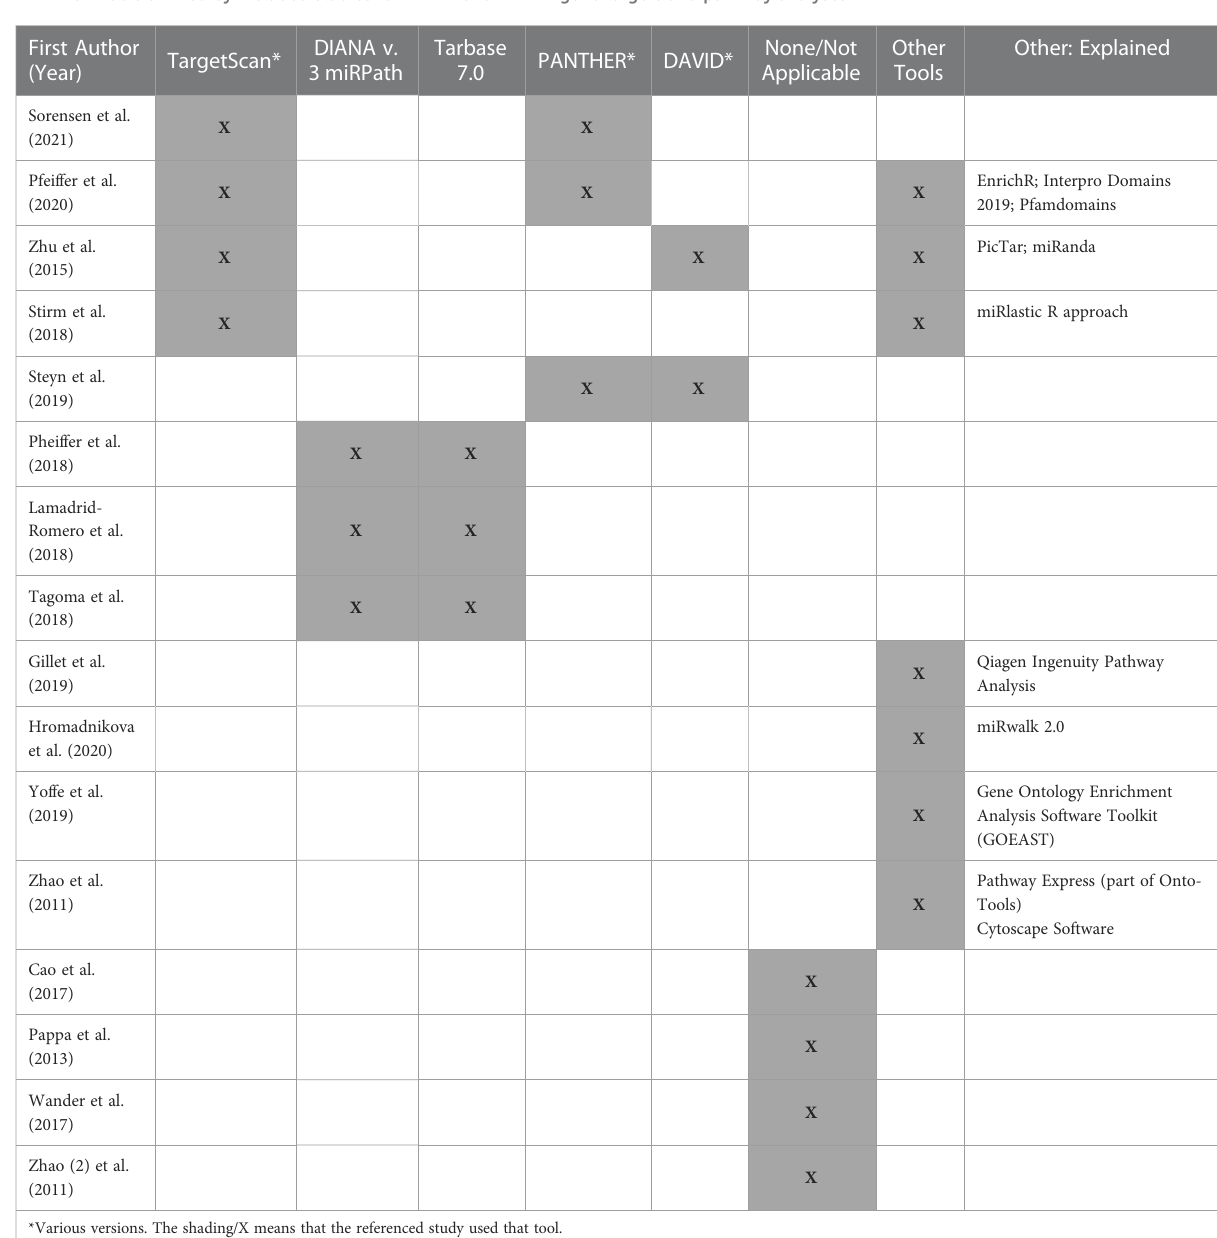
TABLE 3 Tools utilized by included studies for mRNA and miRNA gene targets and pathway